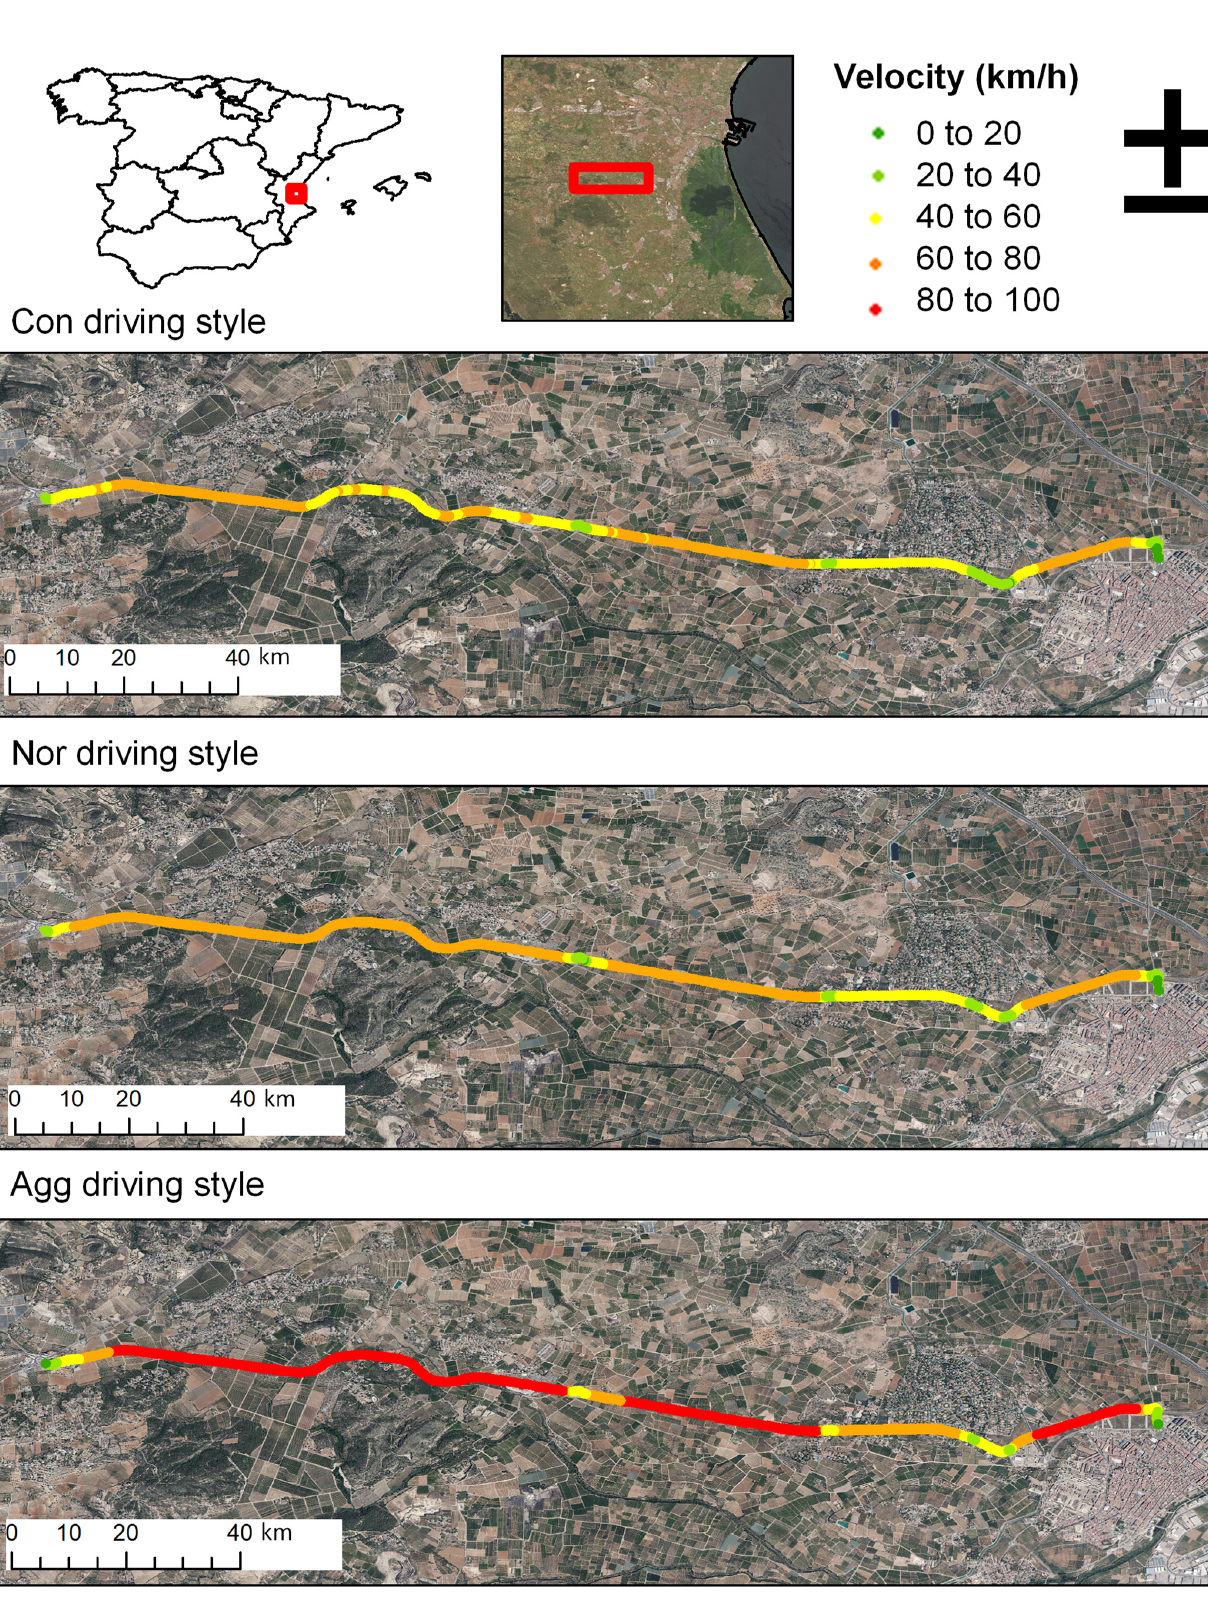
Figure 7. Variation of velocity along the route for the three driving patterns.